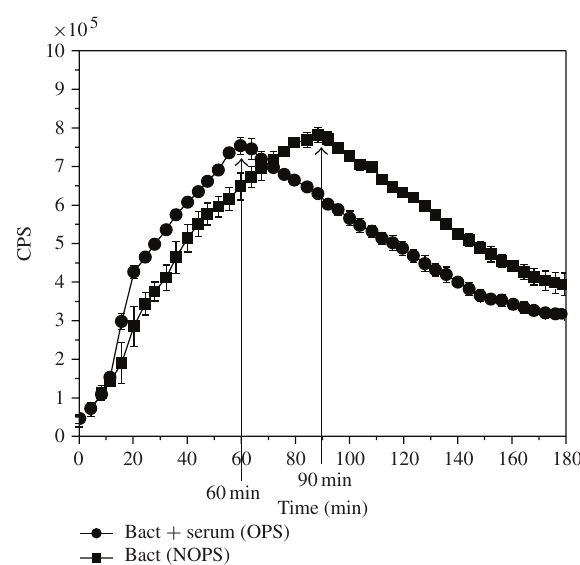
FIGURE 4: The luminol-amplified chemiluminescence (CL) signal of E. coli -lux (1 × 10 6 cells) with 2.5 × 10 5 neutrophils and 0.4 % serum in gHBSS medium at 37 ◦ C. ( • ) bacteria + serum (OPS) and ( (cid:2) ) bacteria (NOPS). Counts per second (CPS) values are shown as the mean ± SD of measurements from four parallel wells. Arrows point out the peak times of the CL